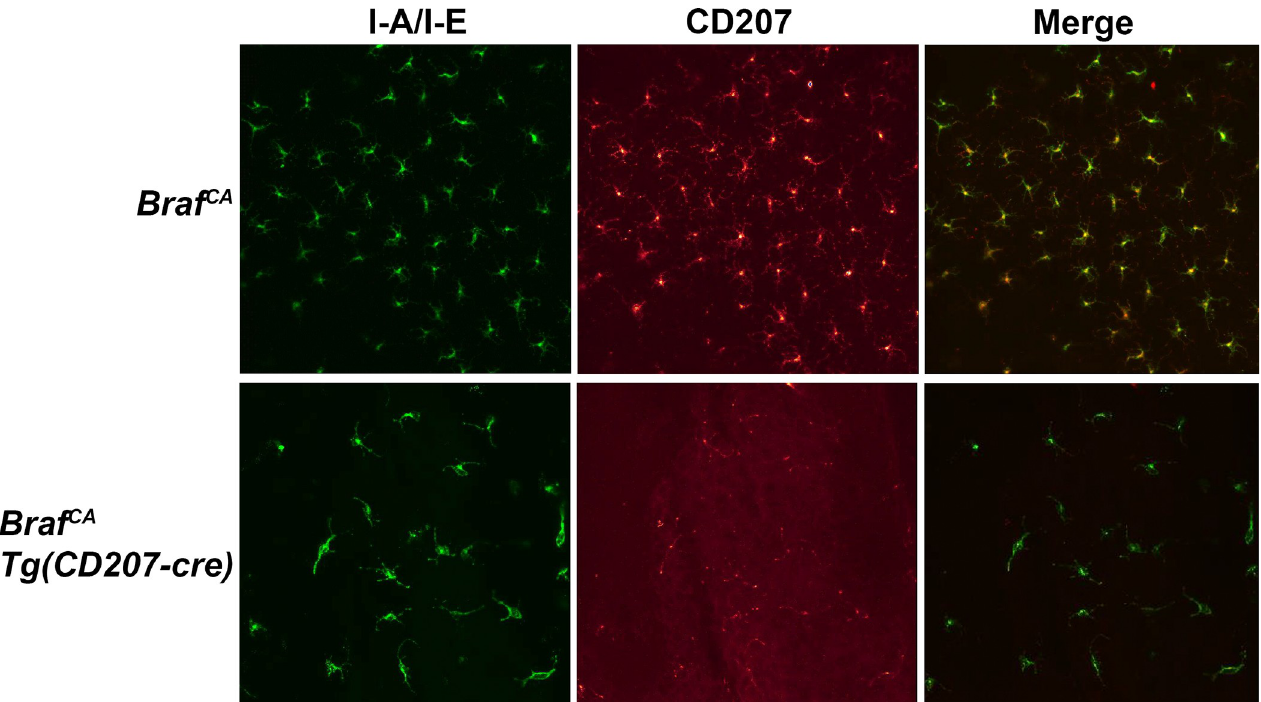
Fig 6. Epidermal Langerhans cells identified by immunofluorescence in Braf CA and Braf CA Tg(CD207-cre) mice. Epidermis was prepared from the ears of 43 day old mice of the indicated genotype as described in Materials and Methods. Immunofluorescence imaging was performed using antibodies directed against MHC Class II (I-A/I-E, green) and CD207 (red). Merged images are also shown indicating that nearly all I-A/I-E + cells are also CD207 + in Braf CA mice, identifying these cells as Langerhans cells. In Braf CA Tg(CD207-cre) mice, most Langerhans cells have reduced CD207 expression.